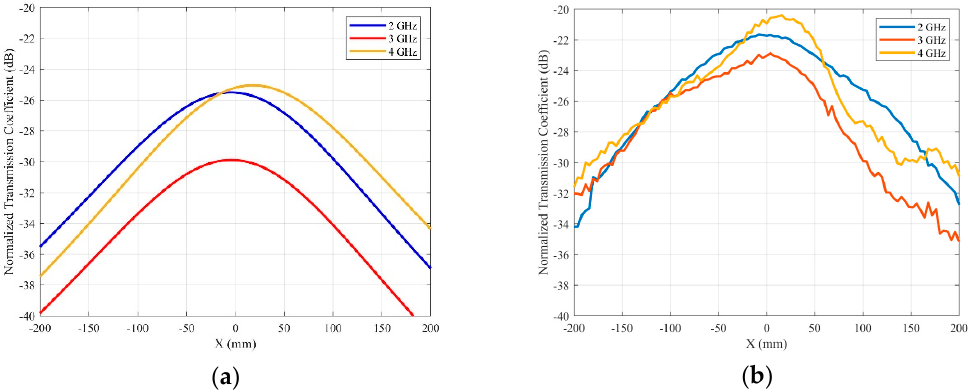
Figure 11. Normalized transmission coefficient for the back radiation of the Jerusalem cross slot antenna. ( a ) Simulations. ( b ) Measurements.